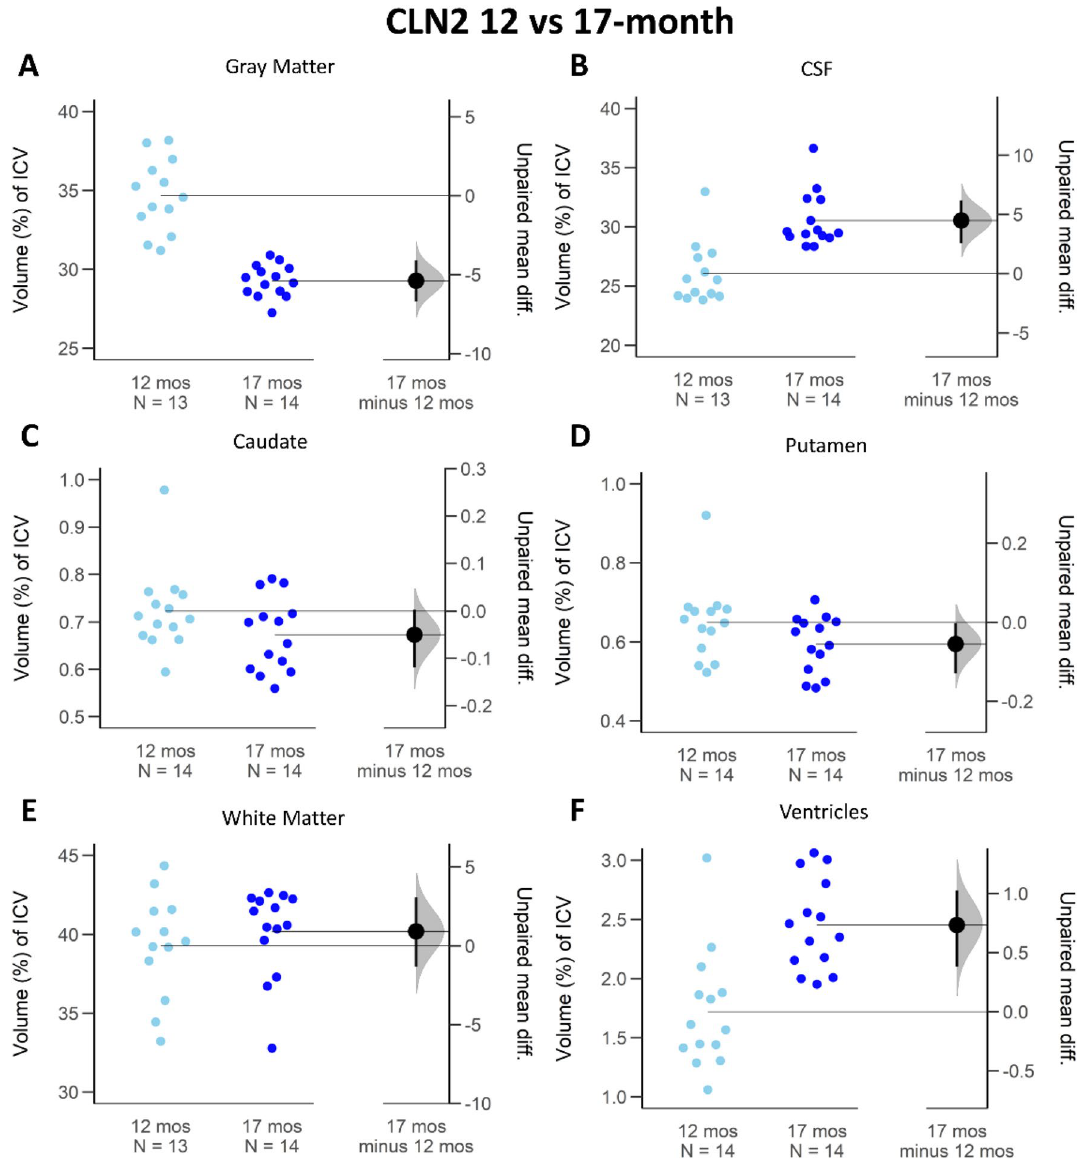
Figure 5. ICV proportion comparison of brain regions between 12- and 17-month-old CLN2 R208X/R208X minipigs. The average difference and 95% confidence interval (black circle with error bar in 17 mos minus 12 mos column ) do not cross the horizontal line at zero and indicates reliable measurement difference between the cohorts in gray matter ( A ), CSF ( B ), putamen ( D ), and ventricles ( F ). When the average difference and 95% confidence intervals (black circle with error bar in 17 mos minus 12 mos column) cross the horizontal line